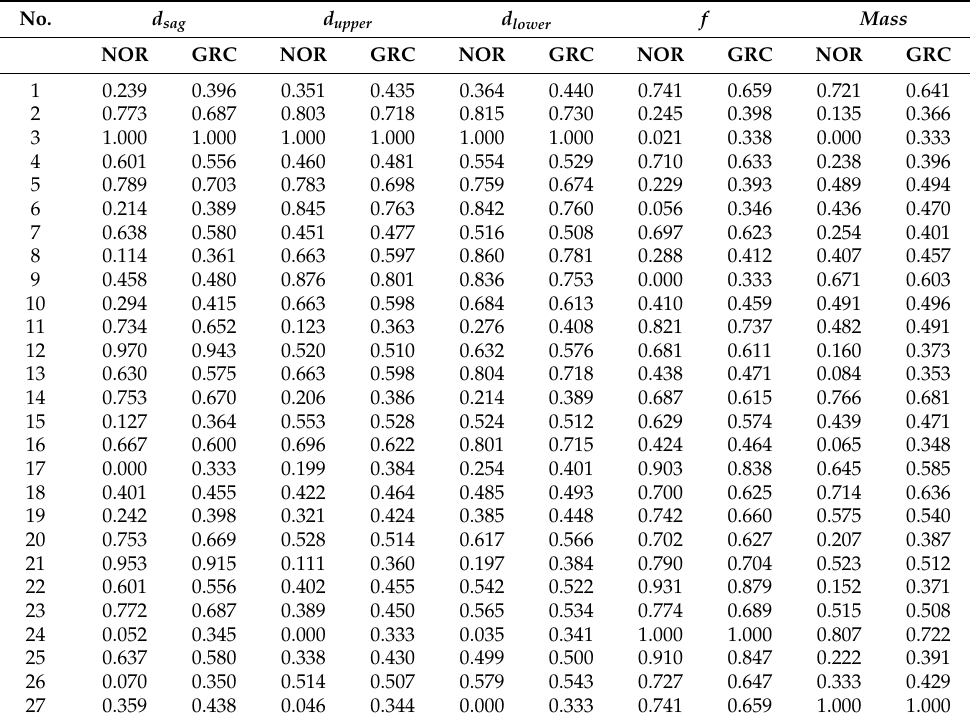
Table 6. Normalisation of S/N ratios (NOR) and grey relational coefficient (GRC) for each perfor- mance characteristic.